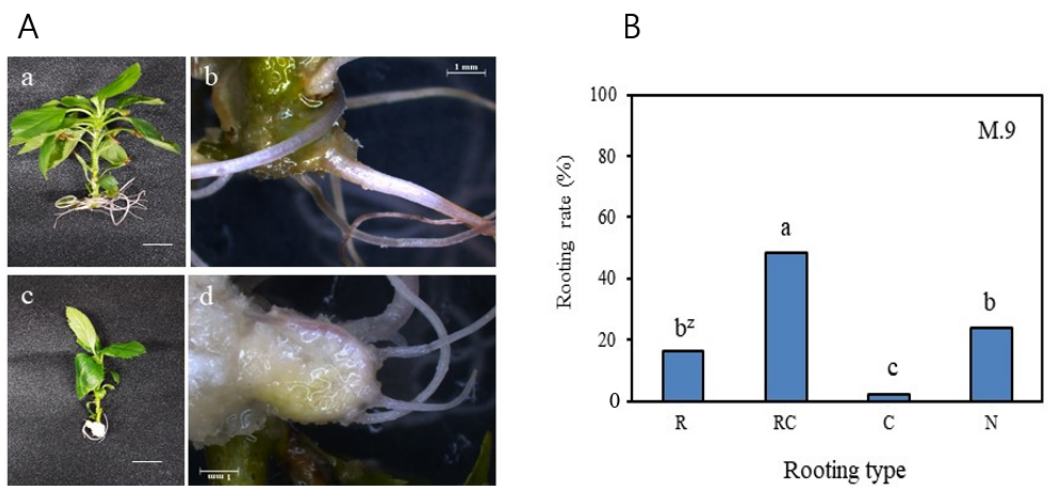
Figure 3. Rooting and callus formation in apple rootstock M9 after 4 weeks of culture on MS medium containing 0.5 mg·L − 1 IBA. ( A ) True-to-type roots ( a , b ) and indirect roots induced from callus ( c , d ).